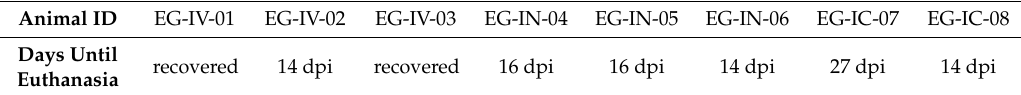
Table 2. Summarized length of protocol for sheep inoculated with SPPV-“Egypt /